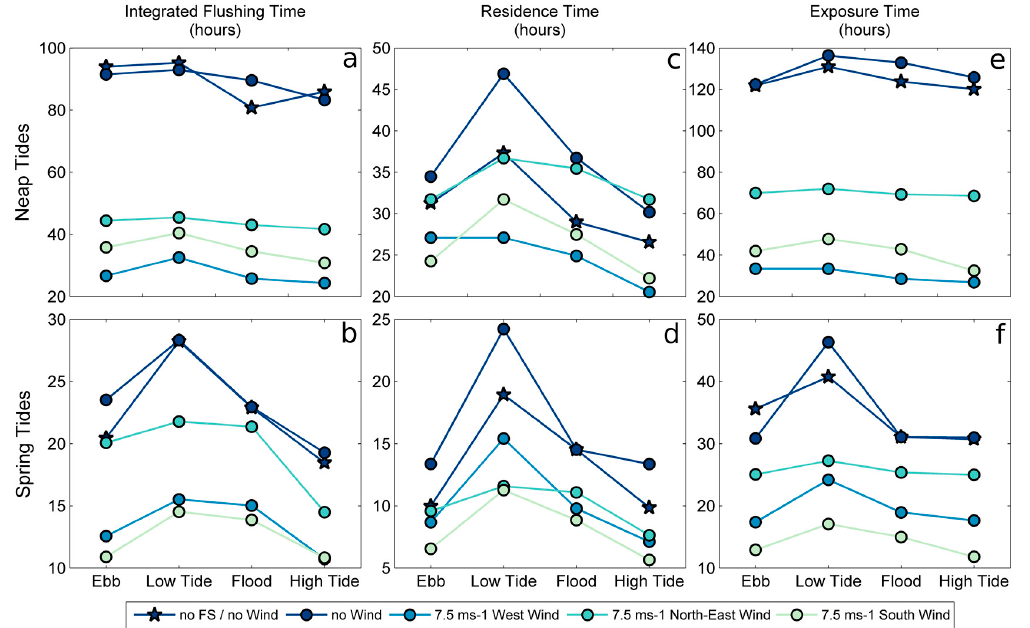
Figure 7. Spatially-averaged timescales values obtained for each release (at Ebb, Low Tide, Flood and High Tide) for each scenario.